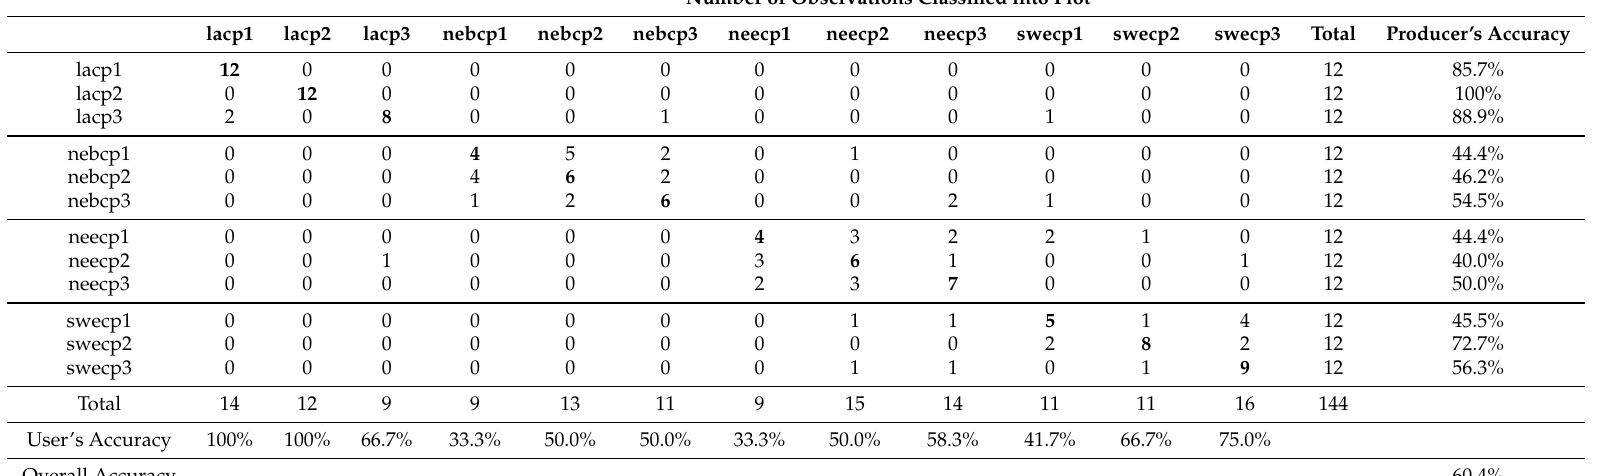
Table 4. Confusion matrix for summer 2014 discriminant analysis to test discriminabilty of plots using 7 simulated WorldView2 bands: 400–449, 450–509,